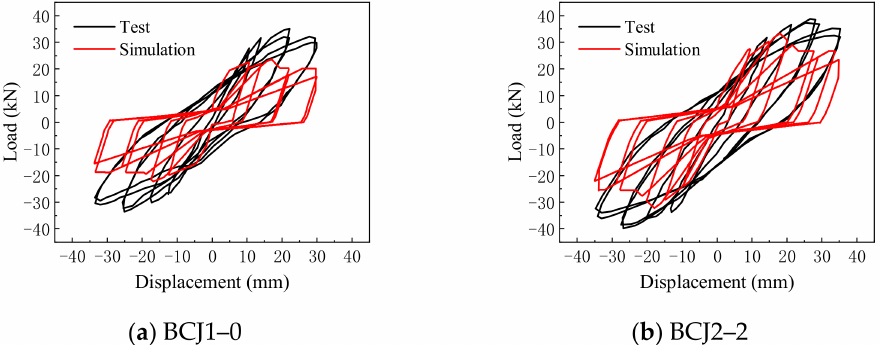
Figure 8. Comparison of hysteretic curves.